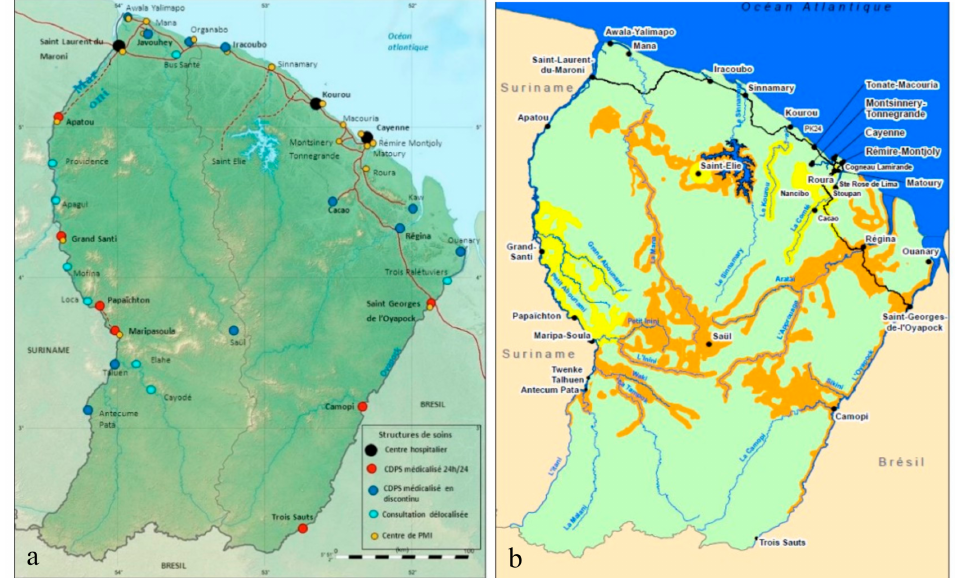
Figure 1. ( a ) Locations of Delocalized Centers for Prevention and Care health centers and hospitals in French Guiana. Malaria risk map ( b ), green areas are where there was no malaria transmission in the previous year (2017), yellow areas indicate low risk of malaria but no transmission in the villages, and orange areas indicate high risk of malaria transmission [20]. Figure 1b has been produced with the assistance of: French Guiana territorial collective, French Guiana Health Agency, Malaria National Reference Center of French Guiana, French Guiana armed forces, Delocalized Prevention and Care Centers (CDPS) of Cayenne Hospital, Medical Biology Laboratory of French Guiana, Cire of French Guiana and France Public Health